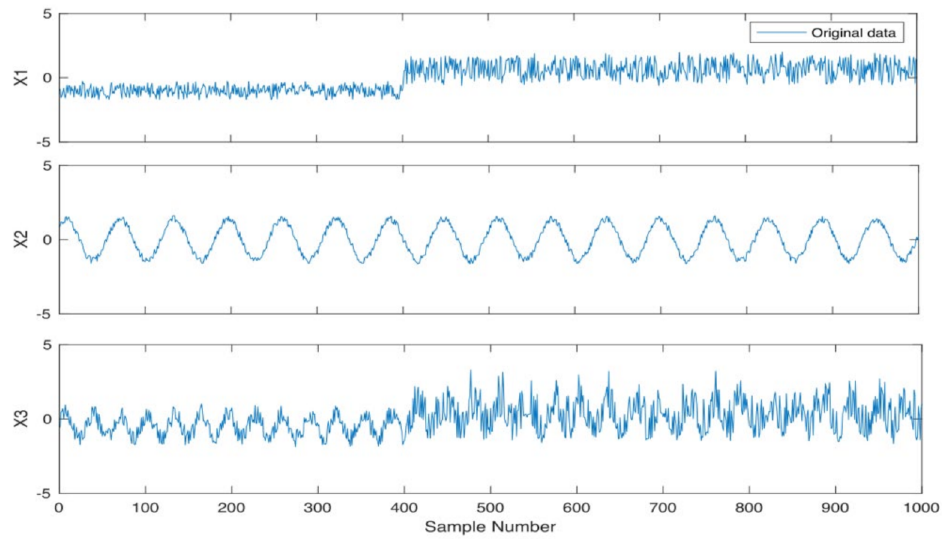
Figure 2. The time evaluation of generated